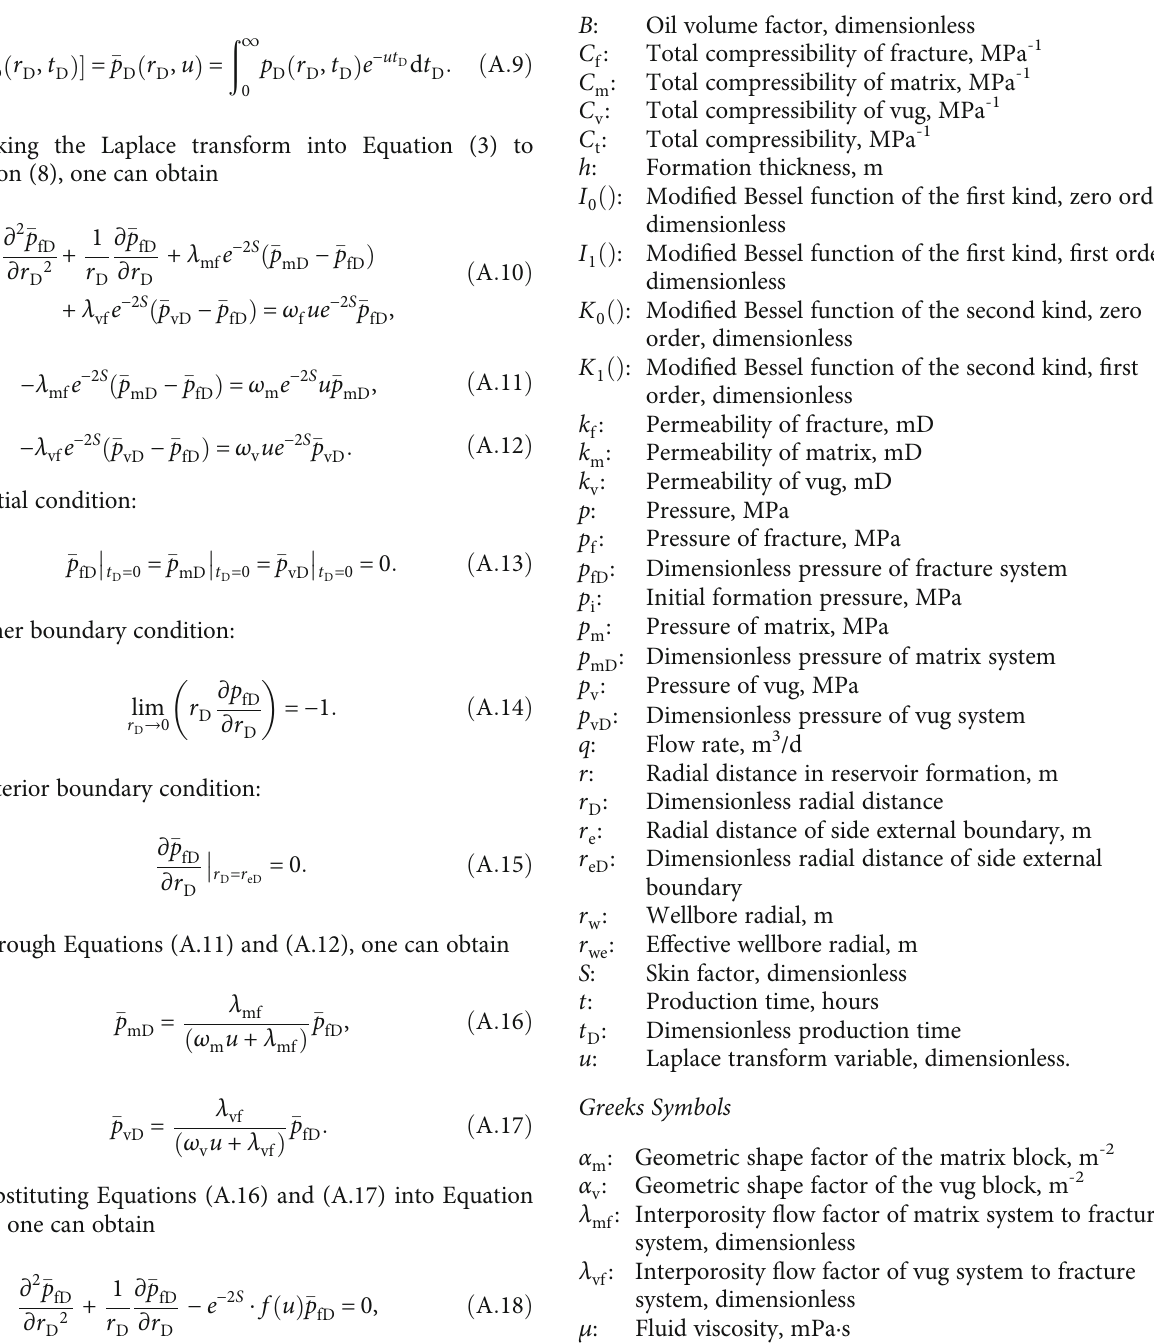
Laplace transform is used to solve the established model